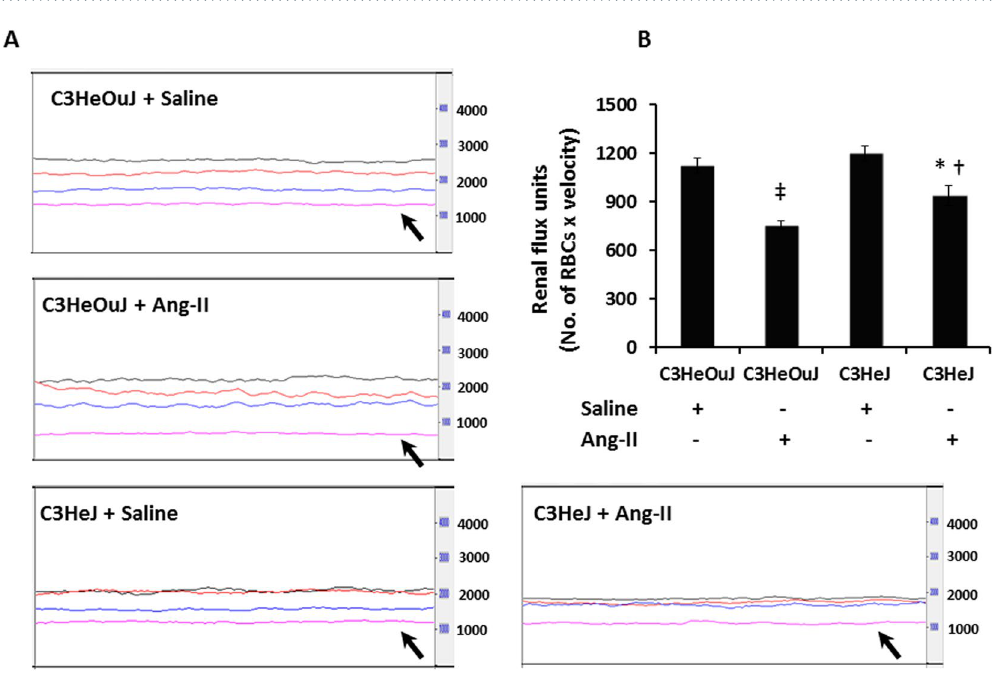
Figure 3. TLR4 deficiency mice maintain better renal cortical blood flux than mice with normal TLR4 in response to Ang-II treatment. ( A ) Representative line tracing of aorta (black), renal artery (red), renal vein (blue) and renal cortex (pink). ( B ) Data shows mean flux ± SEM. n = 6/group tested by ANOVA and Student’s t-test. RBC, red blood cell. * p < 0.05 vs. C3HeJ + saline, † p < 0.05 vs. C3HeOuJ + Ang-II, ‡ p < 0.05 vs. C3HeOuJ + saline. C3HeOuJ: normal TLR4, C3HeJ: TLR4